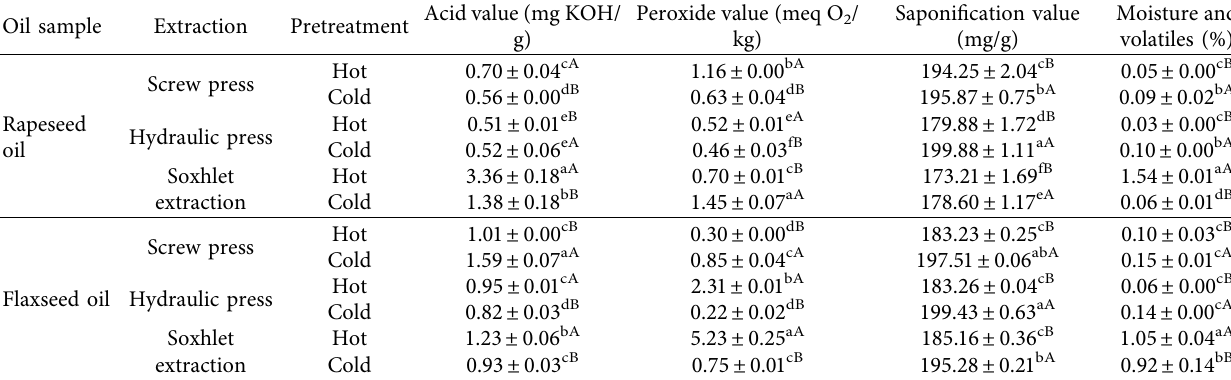
Table 1: Physicochemical properties of rapeseed and flaxseed